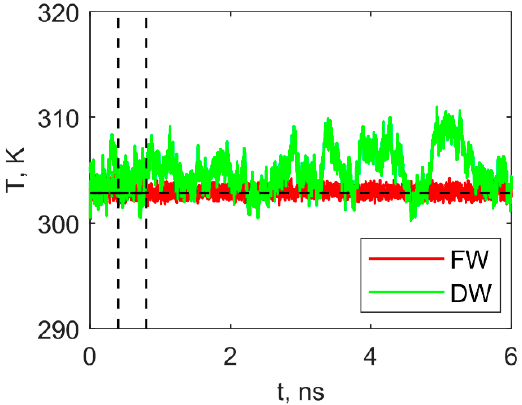
Figure 3. Water temperature–time evolution in FW and DW simulations when the force inducing the flow was 𝑓 (cid:3051) = 3.53 × 10 (cid:2869)(cid:2870) N/kg . Horizontal dotted line displays the average temperature of the copper in simulation with dynamic walls, while two vertical dotted lines is used as markers to sep- arate the simulation stages.